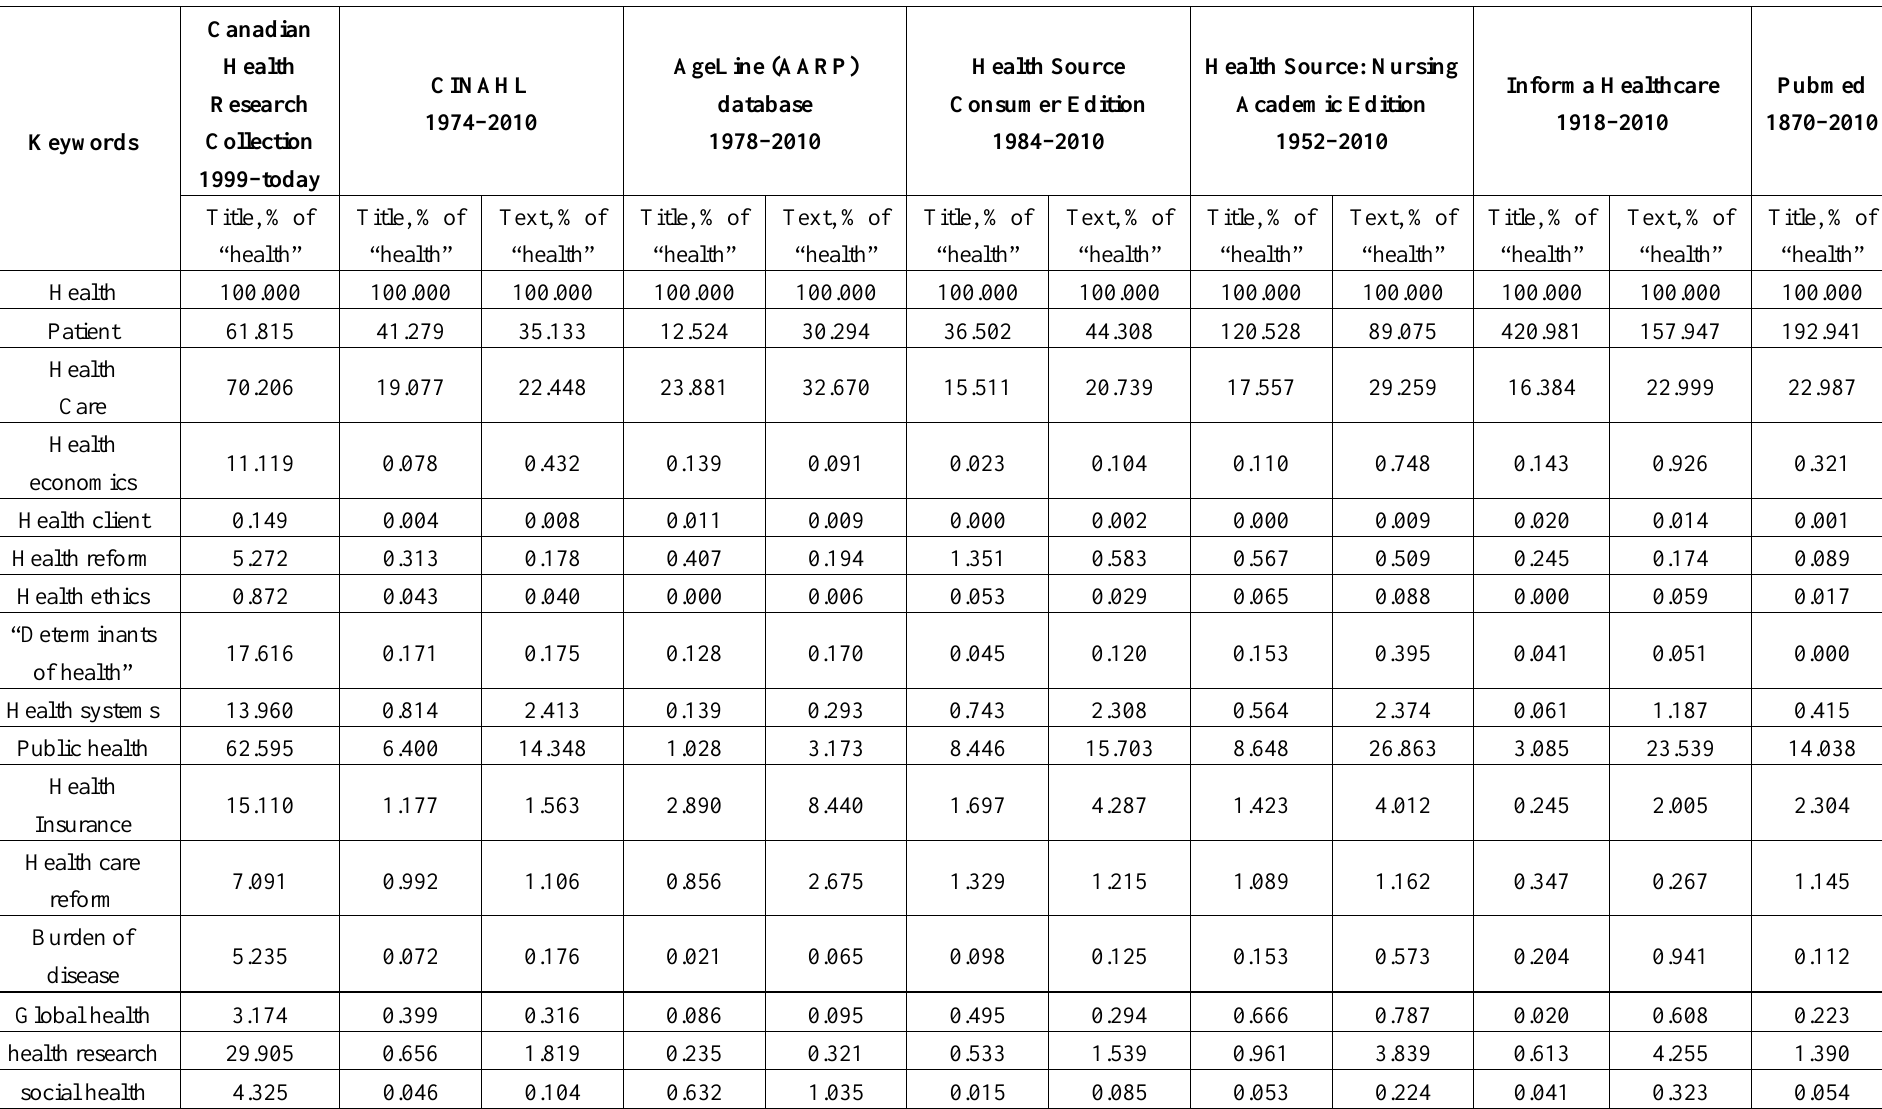
Table 3. Frequency of health policy terms covering different areas in Health Journal bundled in different